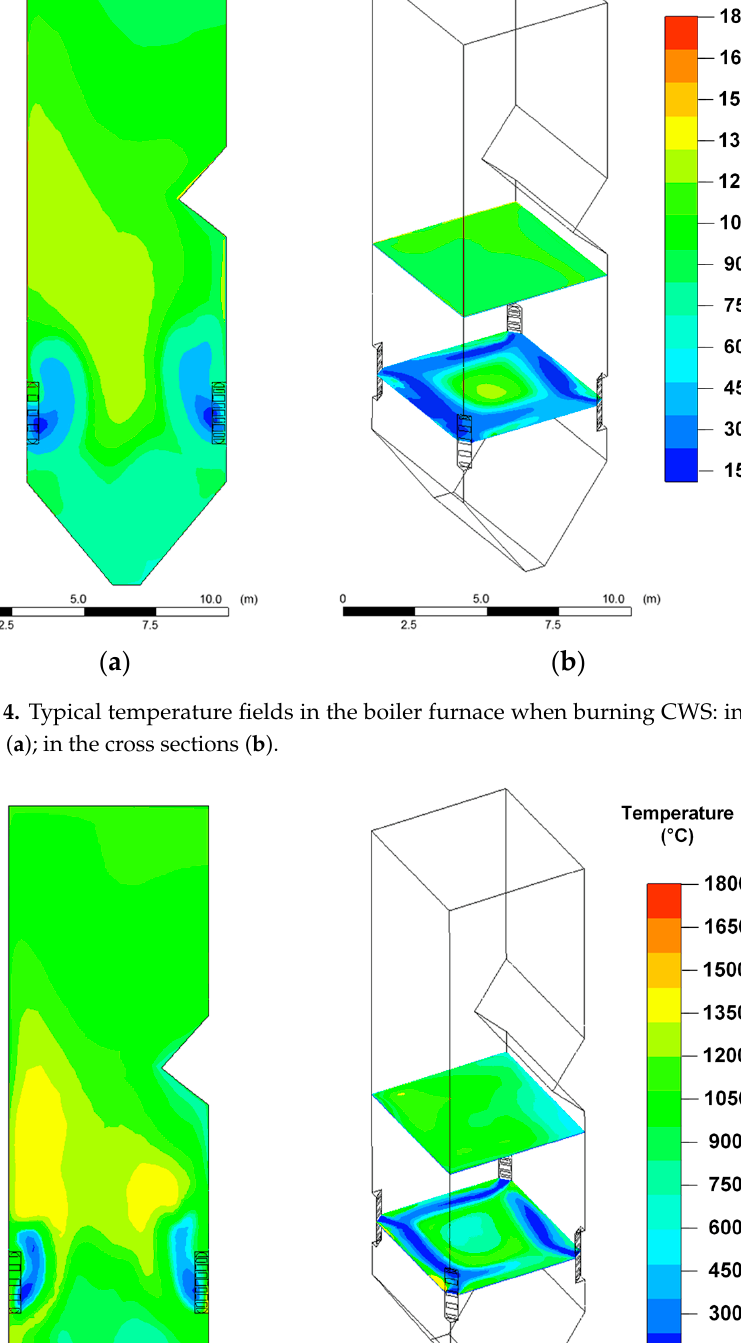
Figure 3. Typical temperature fields in the boiler furnace when burning coal: in the longitudinal section ( a ); in the cross sections ( b ).